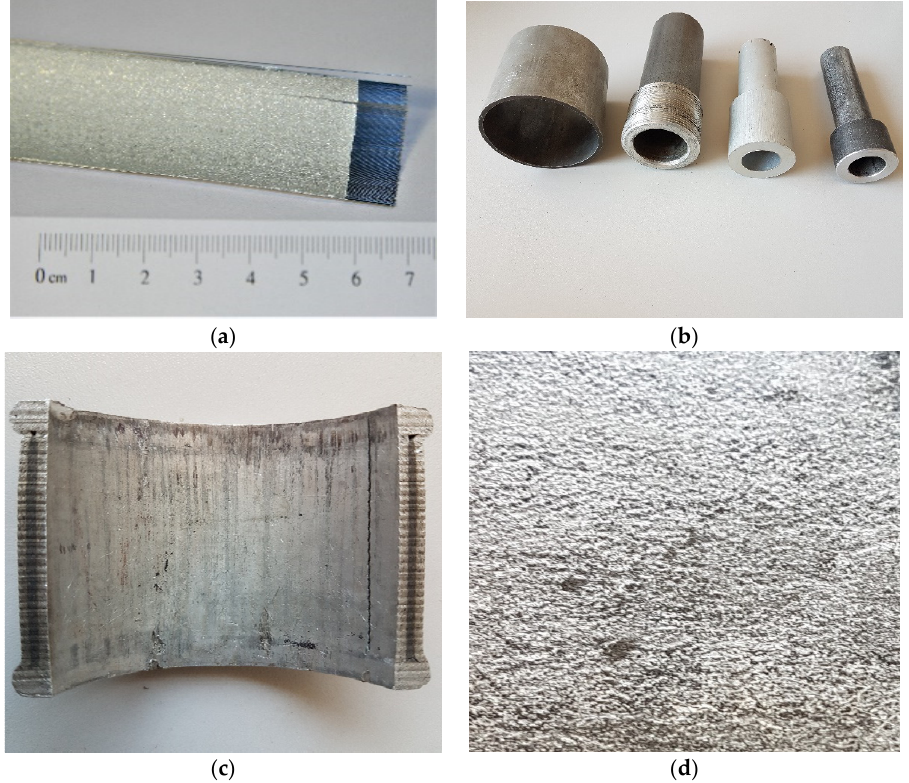
Figure 2. Fragments of (B-W/fibrous composite materials with metal matrices): prepregs from W-B fibres with subsequent aluminium sputtering ( a ); tubes after hot pressing of prepregs (diameter 20—100 mm ( b ); also—in section ( с ); multilayer plate of B-W fibres in a matrix of aluminium alloy ( c ) thickness—4 mm ( d ). The macro and microstructure of Al-W-B are presented on Figure 3.